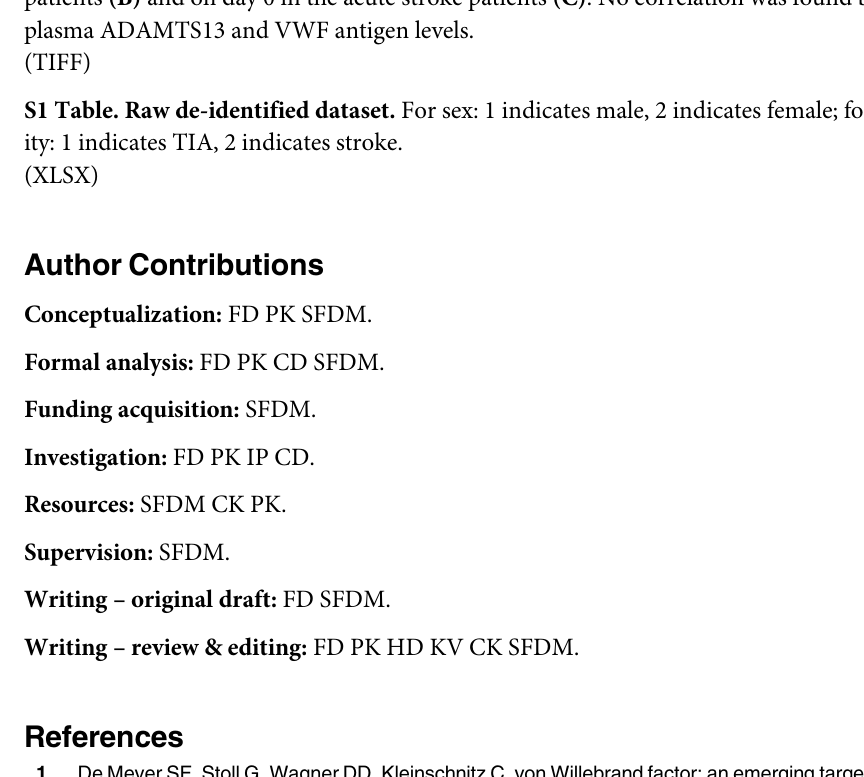
S1 Fig. Time point of blood withdrawal did not influence ADAMTS13 levels or VWF: ADAMTS13 ratio in acute stroke patients. Levels of ADAMTS13 were plotted as a percent- age of the level in a normal human plasma pool (NHP), consisting of pooled plasma from 20 healthy donors. VWF levels were measured previously and were used to calculate the VWF: ADAMTS13 ratios. Both ADAMTS13 levels (A) and VWF:ADAMTS13 ratios (B) are depicted in box-and-whisker plots indicating the first and third quartiles as well as the interquartile range (IQR, Tukey plot). Outliers outside the 1.5 IQR are visualized by single dots. Data were analyzed using a Kruskal-Wallis test with a Dunn’s multiple comparison test. (TIFF) S2 Fig. Correlation analysis between ADAMTS13 and VWF levels. A spearman correlation analysis was performed for the healthy volunteers (A) , the chronic cerebrovascular disease patients (B) and on day 0 in the acute stroke patients (C) . No correlation was found between plasma ADAMTS13 and VWF antigen levels. (TIFF) S1 Table. Raw de-identified dataset. For sex: 1 indicates male, 2 indicates female; for modal- ity: 1 indicates TIA, 2 indicates